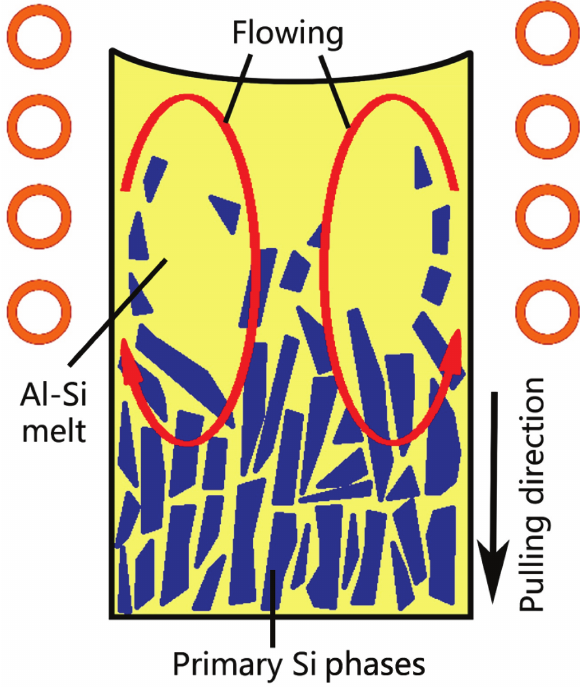
Figure 8: Schematic drawing of electromagnetic stirring mechanism.